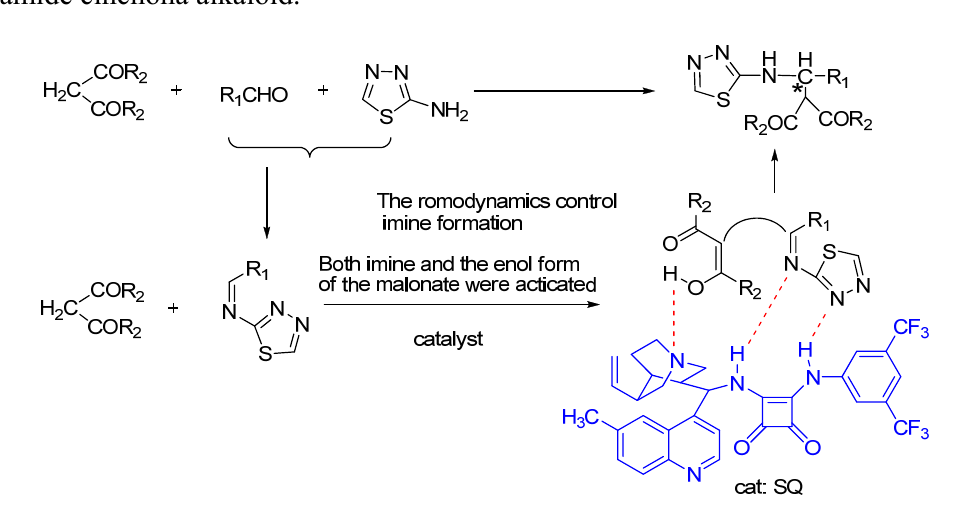
a Reactions were carried out with 1.0 mmol of 1 , 1.2 mmol of 2 , and 1.5 mmol of 3 in 2.0 mL of toluene in the presence of 10 mol% catalyst SQ at 60 °C for 90–110 h. b Isolated yields after chromatographic purification. c ee Determined by HPLC analysis (Chiralpak